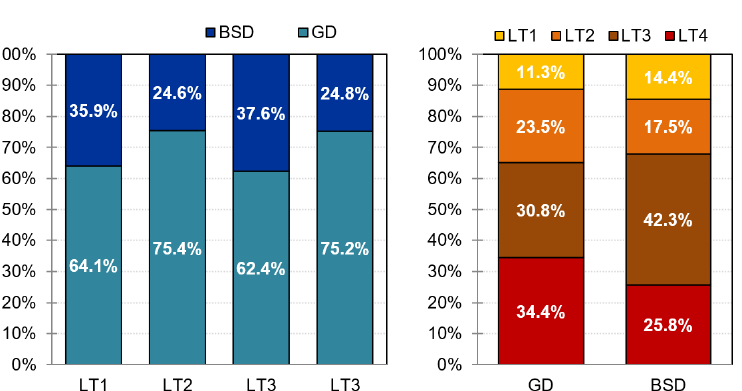
Figure 2. Distribution of the diagnostic subtype within each latent class. Note. BSD: buying/shopping disorder; GD: gambling disorder; LT: latent class; LT1: good progression to recovery; LT2: middle progression; LT3: bad progression to dropout; LT4: bad progression to relapse. Table 4 also shows the distribution of the sociodemographic variables and the com- parison between the latent classes. LT1 was characterized by including the highest